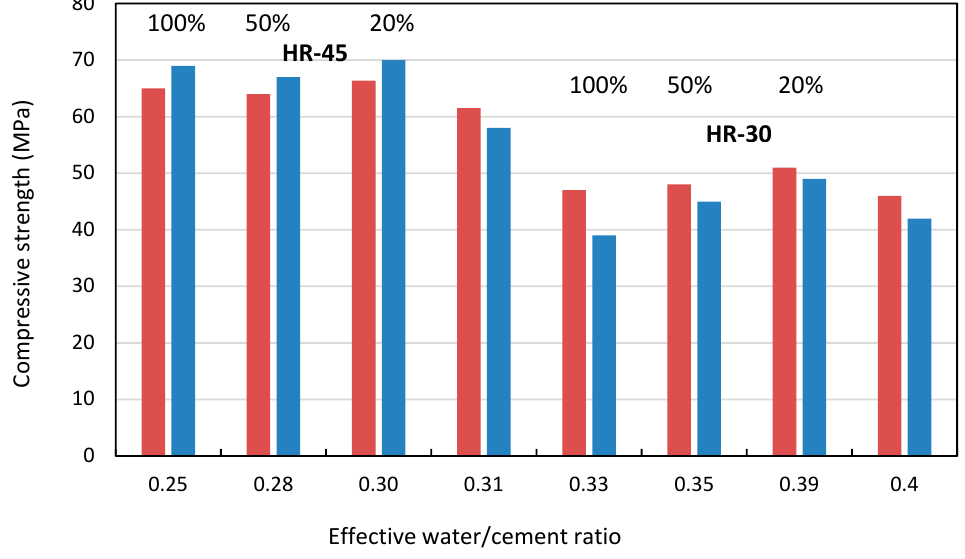
Figure 10. Compressive strength results ( blue ) of the specimens after the freeze-thaw test compared to reference ( red ) specimens, as a function of the e ff ective w / c ratio.